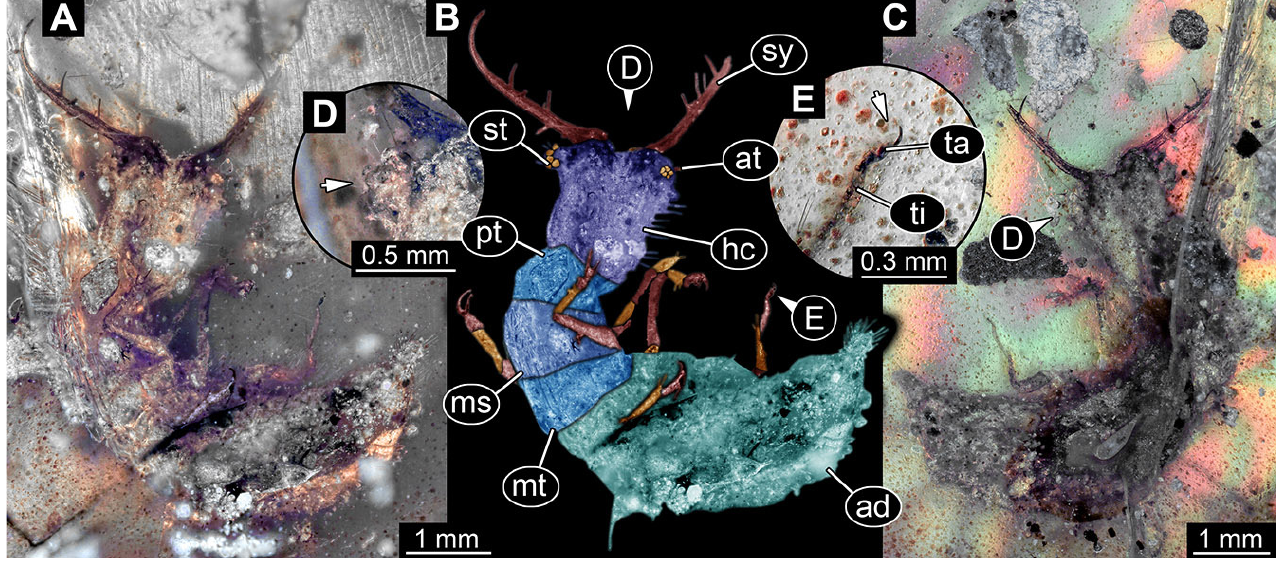
Figure 30. Fossil owllion larva, specimen 3243 (PED 0583), Cretaceous Kachin amber, Myanmar. ( A ) Overview, ventral. ( B ) Color-marked version of ( A ). ( C ) Overview, dorsal. ( D ) Close-up on head capsule with field of stemmata (arrows). ( E ) Close-up on locomotory appendage with claws (arrow). Abbreviations: ad = abdomen; at = antenna; hc = head capsule; ms = mesothorax; mt = metathorax; pt = prothorax; st = stemmata; sy = stylet; ta = tarsus; ti = tibia. 33. Specimen 3244 (PED 0684), preserved in Cretaceous Kachin amber, Myanmar. Spec-